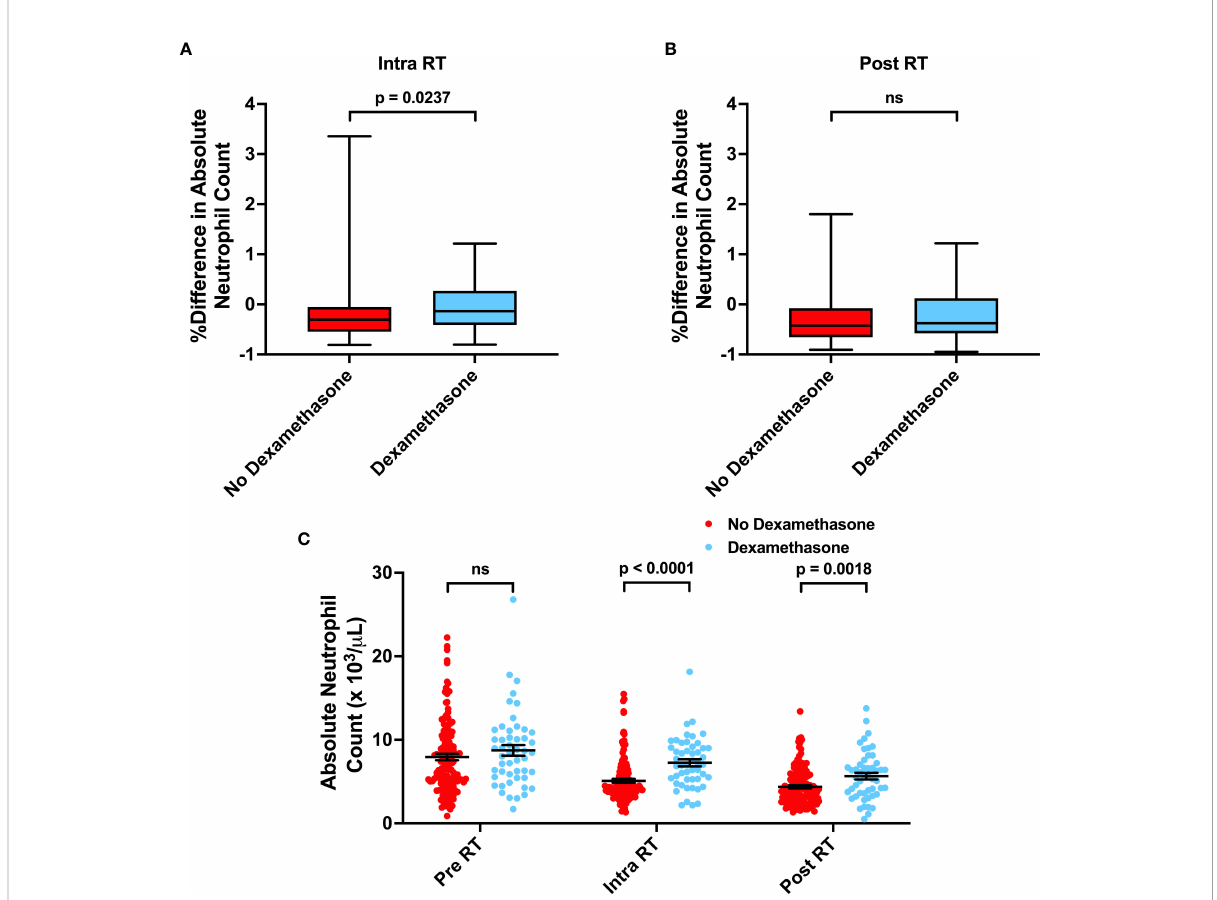
FIGURE 5 Associations between Dexamethasone use and Neutrophil Counts. (A, B) Percent difference in neutrophil counts for patients not receiving or receiving dexamethasone concurrently with radiation. (C) Absolute neutrophil counts before, during, and after RT for patients not receiving or receiving dexamethasone concurrently with radiation. Statistical analysis was performed using two sample t-tests. ns, not signi fi